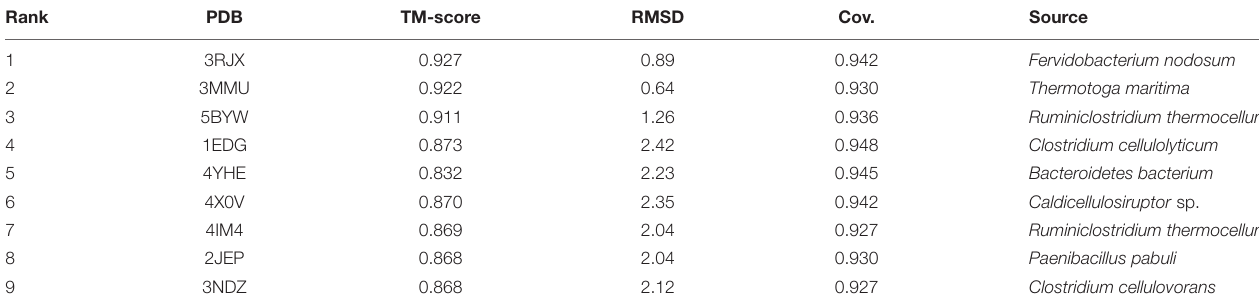
TABLE 2 | Top proteins identified as structural analogs in PDB.